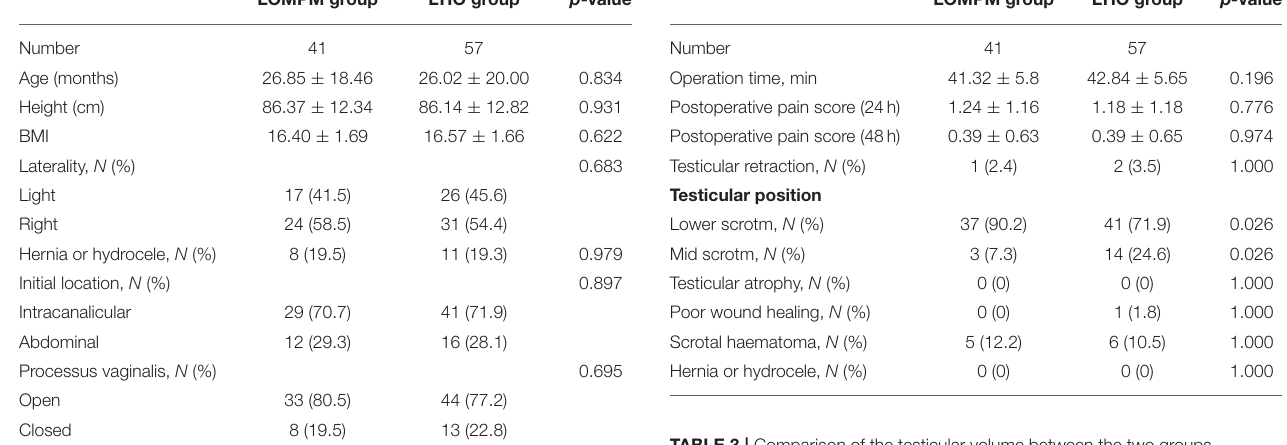
TABLE 3 | Comparison of the testicular volume between the two